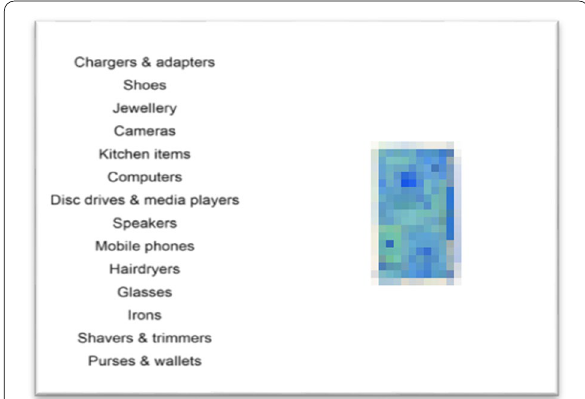
Fig. 2 Example item categorisation training trial from Experiment 1 (also used in Experiments 2, 3 and 4), participants were required to click on the category which matched the object (pixelised stimulus shown for illustrative purposes only—we are unable to share the stimuli used here due to the terms of our license with a commercial